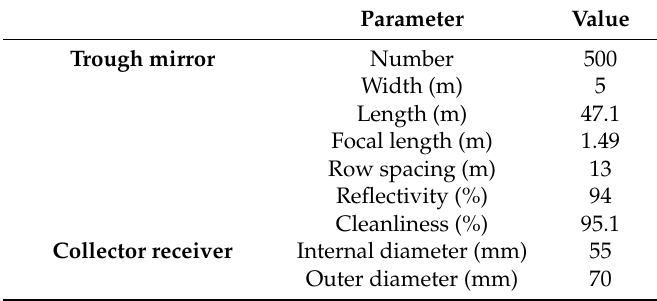
Table 1. The parameters of LS-2 collector.